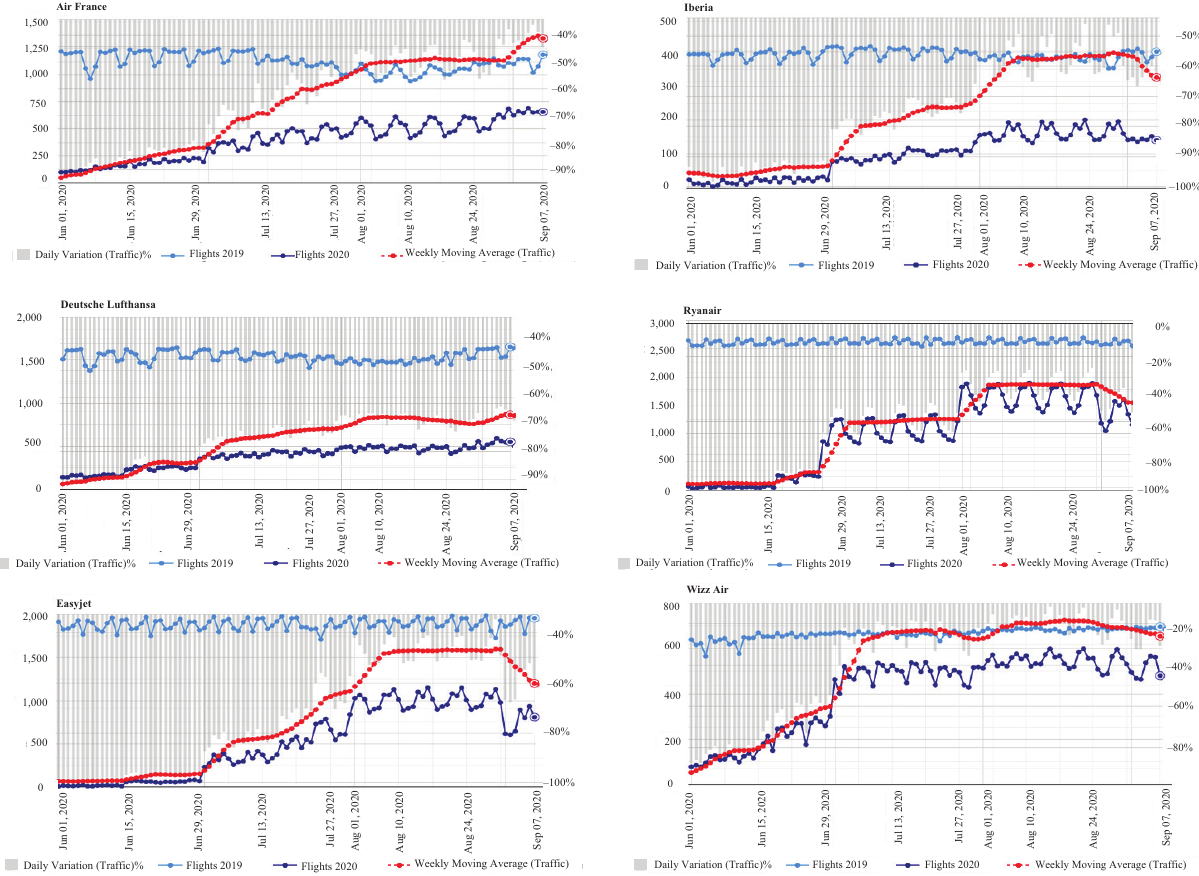
Figure 3. Aircraft operators in Eurocontrol Network (source: Eurocontrol,